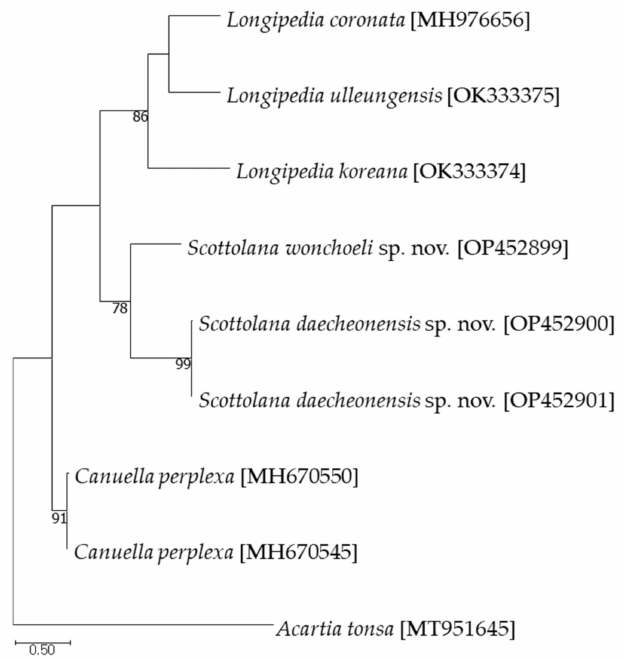
Figure 22. Maximum likelihood tree based on the mitochondrial COI sequences. Numbers above the branches indicate bootstrap values from 1000